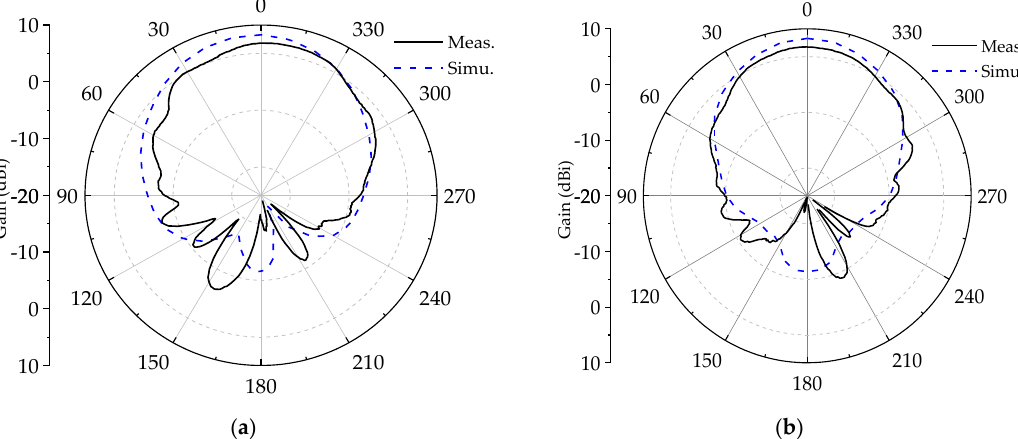
Figure 17. At 5.8 GHz, the measured and simulated radiation pattern of the MIMO antenna. ( a ) E plane; ( b ) H plane.